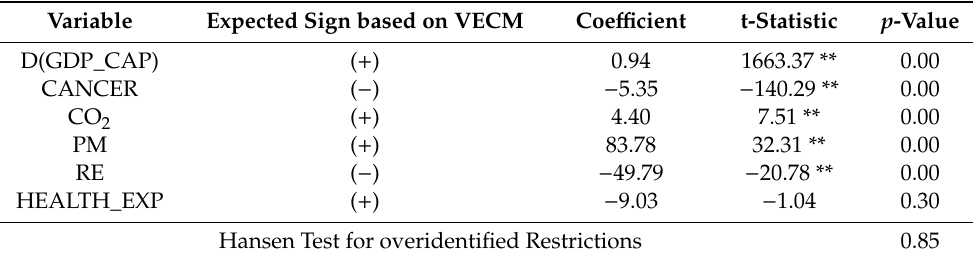
Table 9. Results using the Panel Generalized Method of Moments